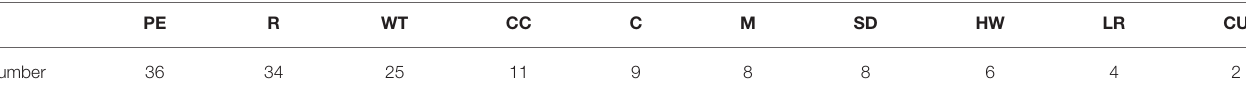
TABLE 5 | Self-training